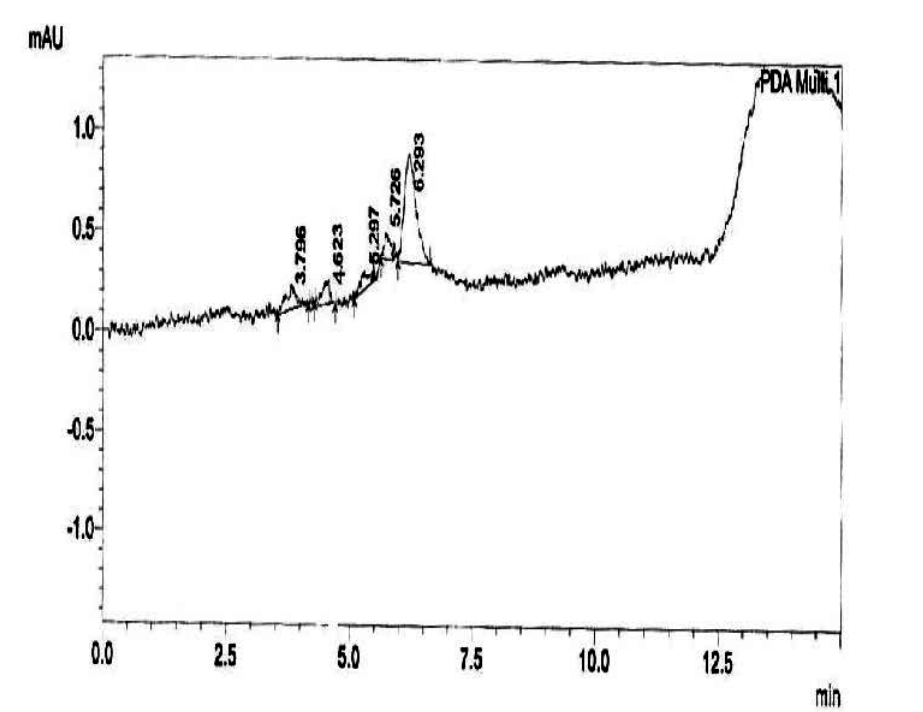
FIGURE 1 - HPLC chromatogram for the determination of Fucose in the test sample , the graph for the test sample Fucoidan extracted from the Turbinaria conoide s shows different peaks with varying Retention time on comparison with standard fucose. The peak with retention time 6.293 that covers the area percentage 46.215 indicates the presence of fucose.